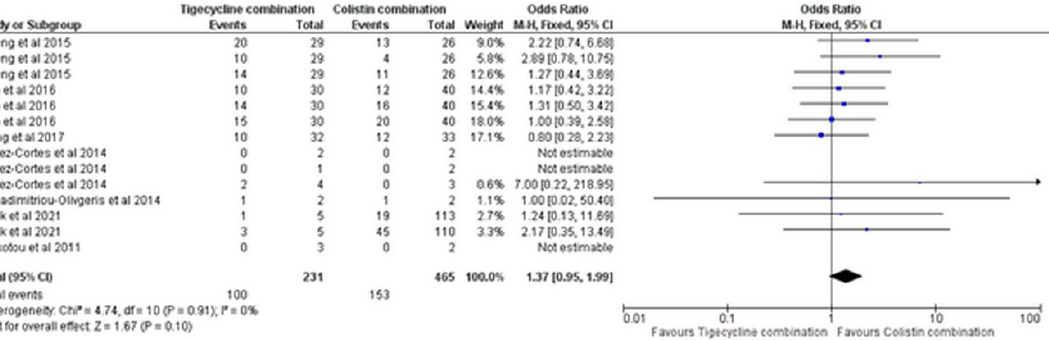
Figure 9. Clinical response of tigecycline combination versus colistin combination [17,20].